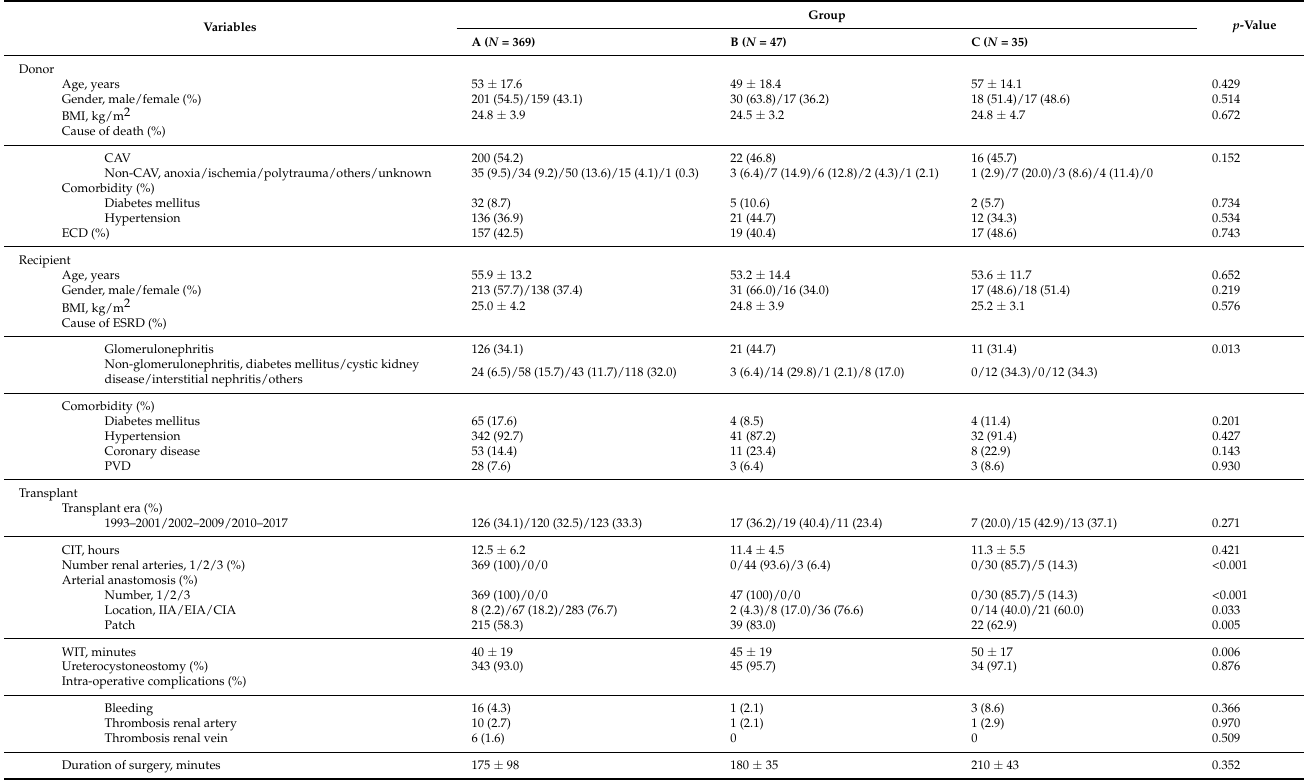
Table 1. Donor, recipient, and transplant